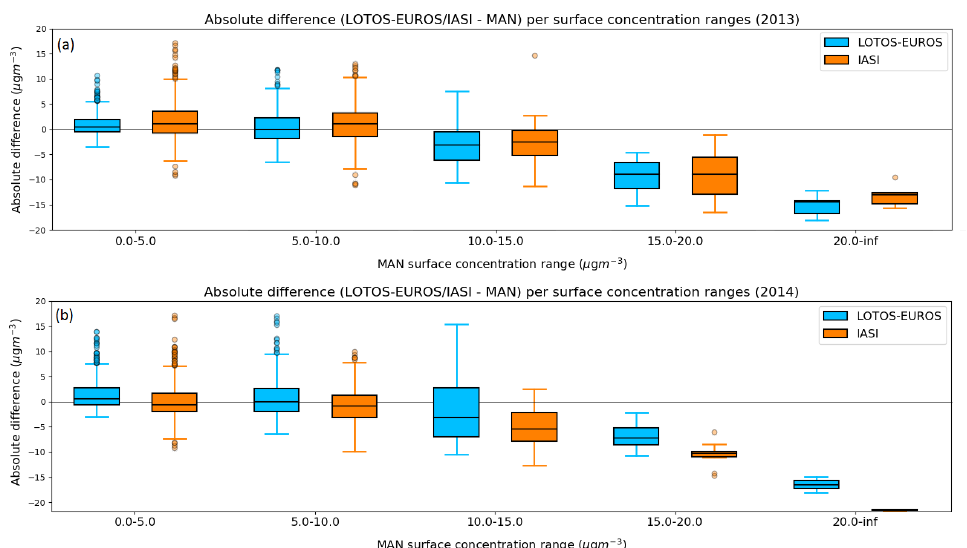
Figure 11. The absolute differences between the monthly mean NH 3 surface concentrations modelled in LOTOS-EUROS (blue) and derived from IASI (orange) and the monthly mean NH 3 surface concentrations measured by the MAN stations in the warm season (April–September) in 2013 (a) and 2014 (b) , grouped as function of the MAN monthly mean NH 3 surface concentrations. The black line indicates the median, the edges of the boxes indicate the 25th and the 75th percentiles (Q1 and Q2), the whiskers indicate the full range of the absolute differences (Q1 − 1.5*IQR and Q3 + 1.5*IQR), and the dots indicate the outliers values that lie outside the